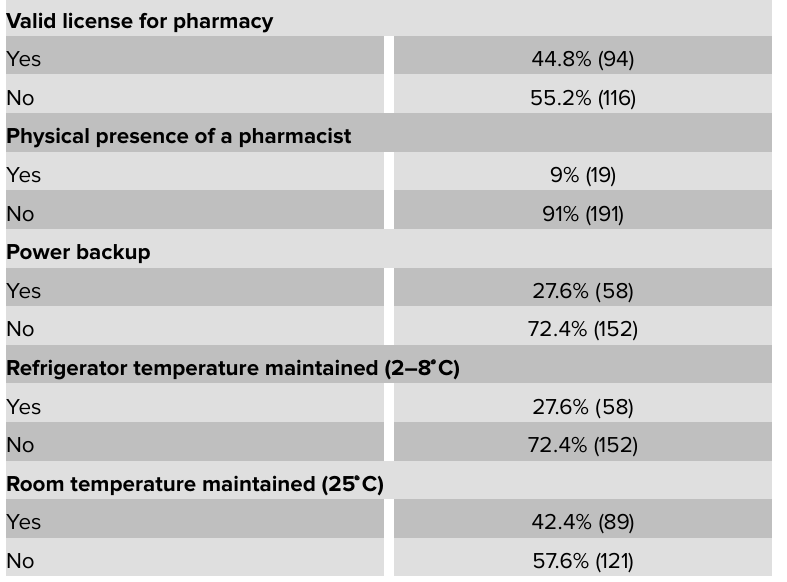
TABLE 2: Medication storage conditions, power backup, pharmacy license, and availability of